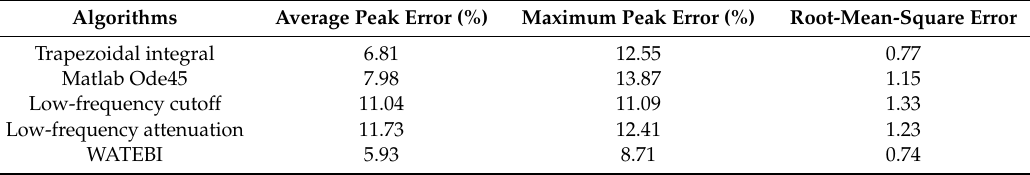
Table 4. Five methods for the displacement reconstruction of El Centro